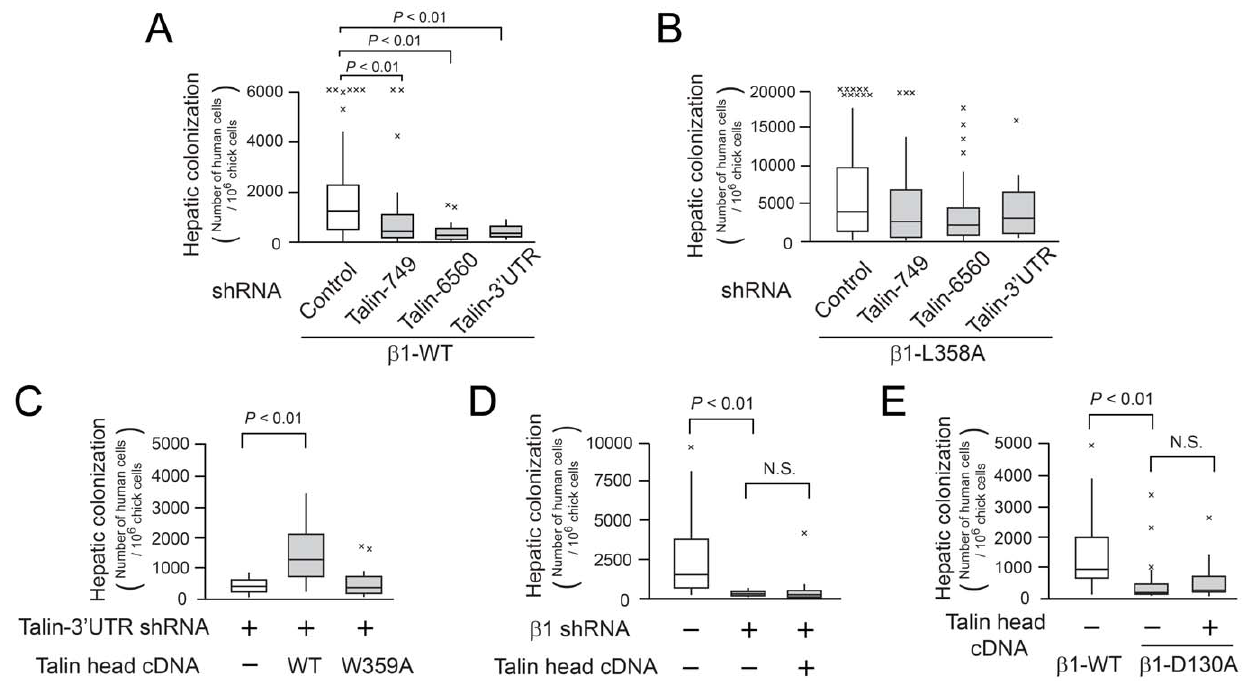
Figure 4. Talin-mediated b 1 integrin activation is required for hepatic colonization by tumor cells. Hepatic colonization in the chick embryo experimental metastasis model. (A and B) Box plots showing the effect of talin knockdown in MDA-MB435 cells. Lentivirus encoding a control shRNA or one of three talin shRNAs were transduced into (A) MDA-MB435 b 1-WT cells or (B) b 1-L358A cells. Box plots depict numbers of human tumor cells quantified in the liver five days after intravenous injection into chick embryos. (C) Effect of wild-type or W359A talin head domain on hepatic colonization in talin knock down cells. (D) Talin head domain cannot rescue the blocking effect of b 1 integrin knock down on hepatic colonization (control: n=14, b 1shRNA: n=15, b 1shRNA + talin head: n=19). (E) Talin knock down cannot rescue the blocking effect of ligand binding- defective b 1-D130A on hepatic colonization ( b 1-WT: n=27, b 1-D130A: n=23, b 1-D130A + talin head: n=19).